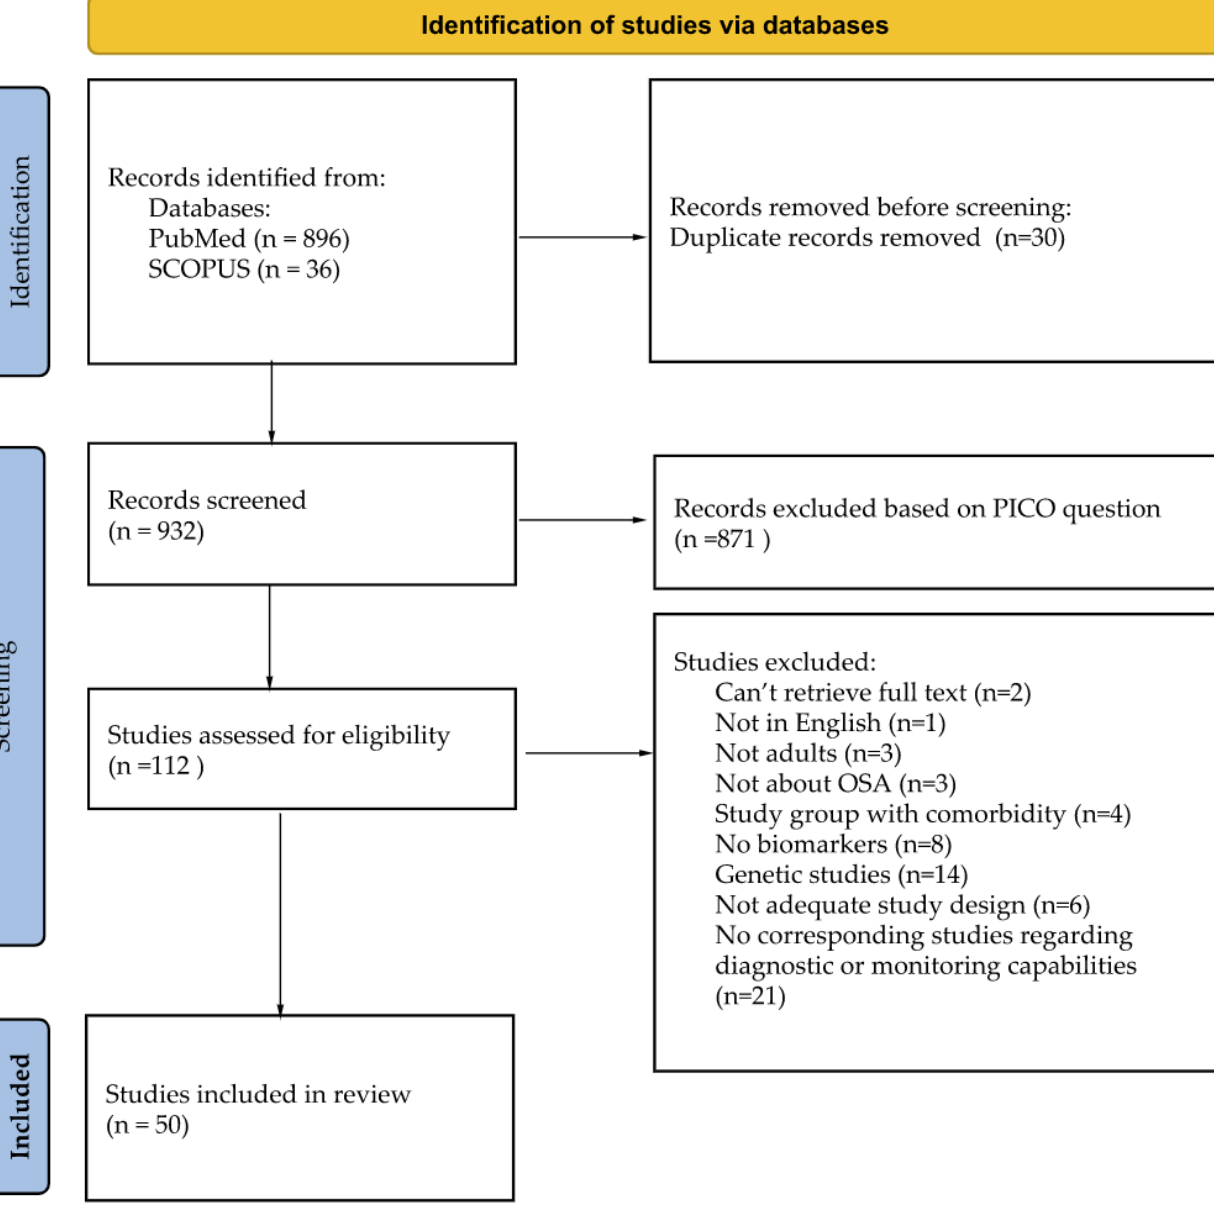
Figure 2. Studies search and inclusion flow chart.